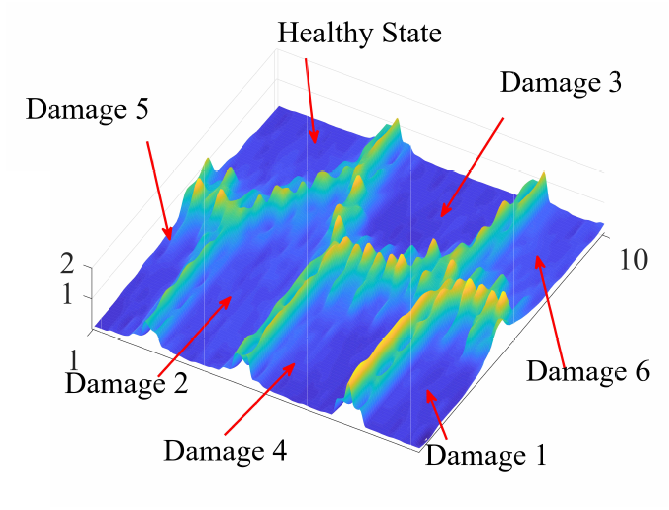
Figure 6. U-matrix